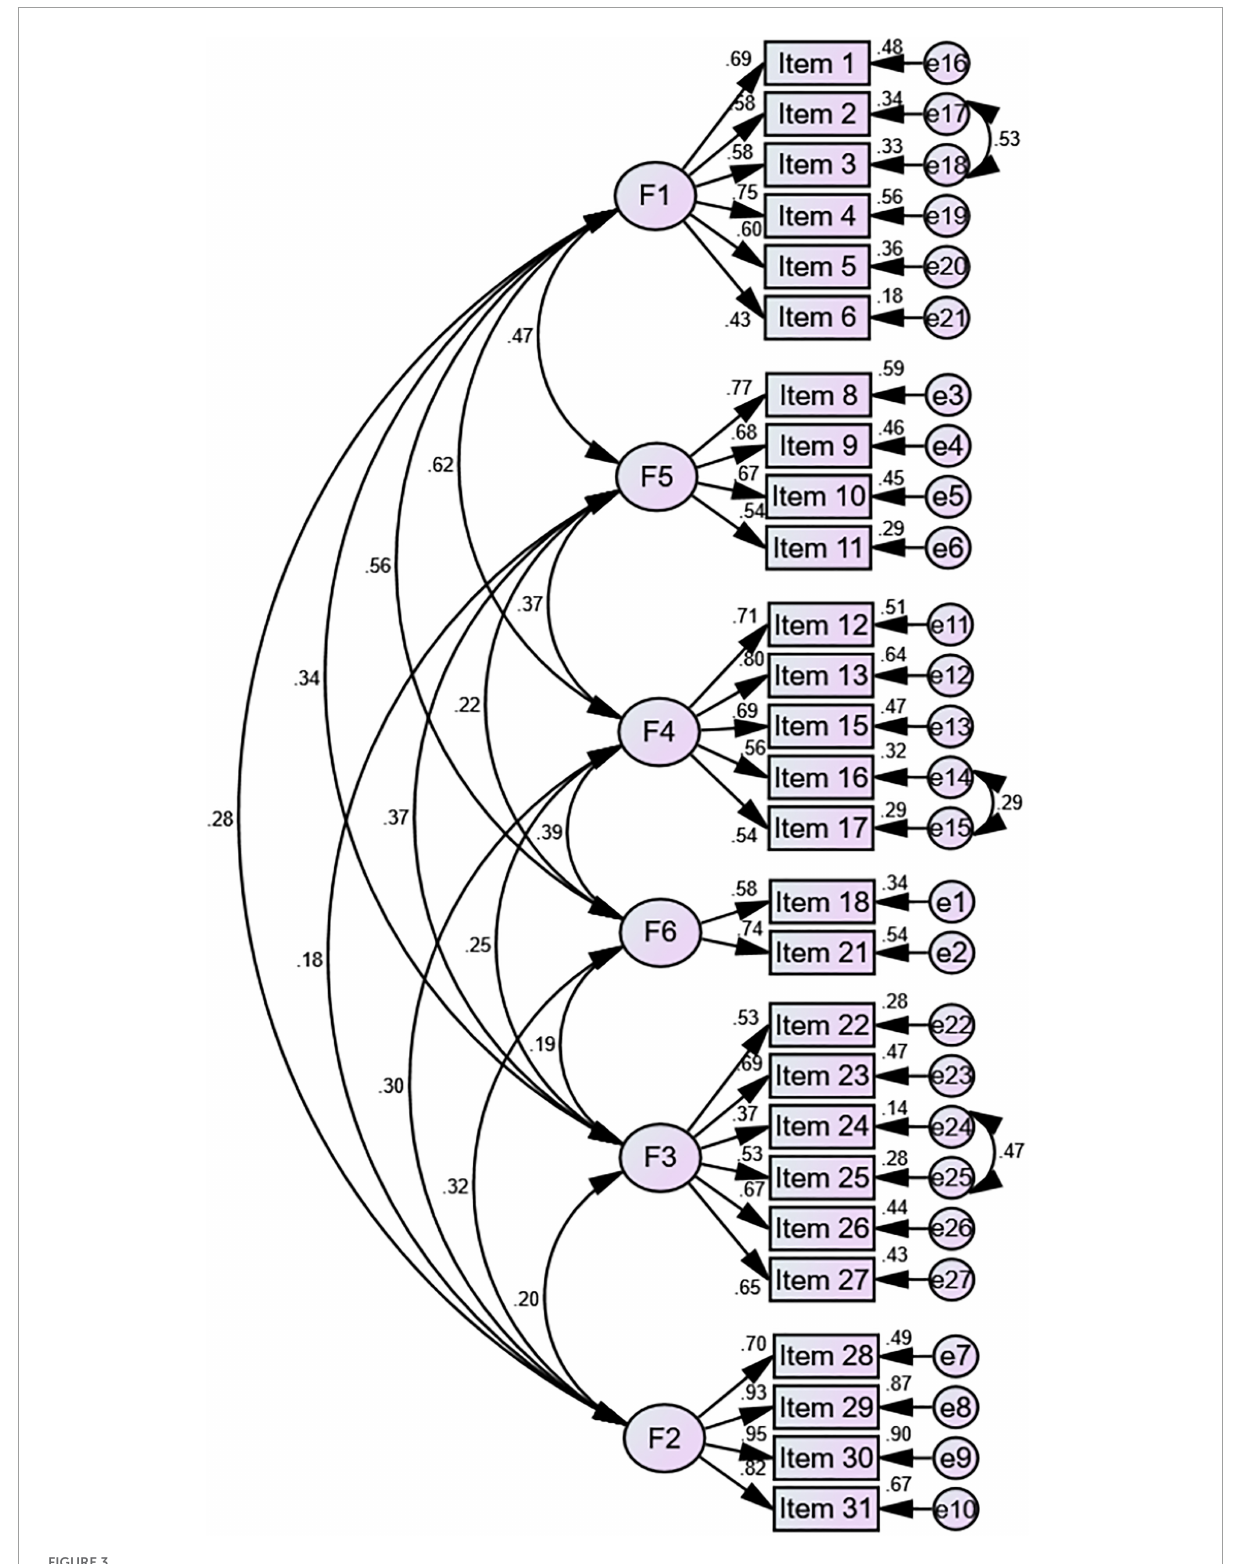
FIGURE3 Modified confirmatory factor analysis of the six factor 27-item